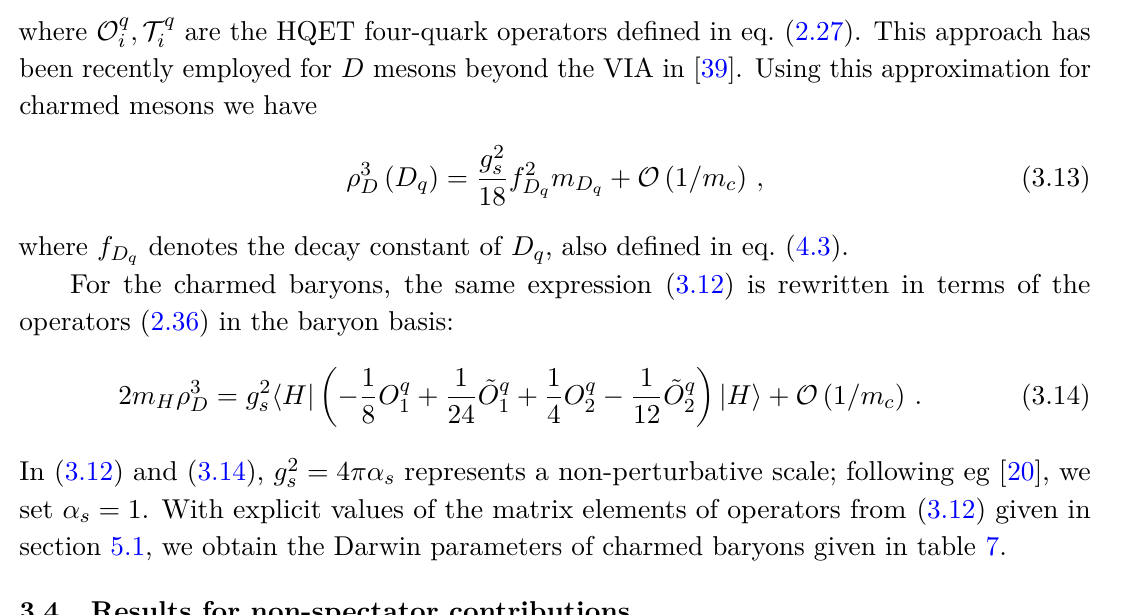
An alternative approach [20] is to relate the Darwin parameter to the matrix elements of the dimension-six spectator contributions by applying the equations of motion for